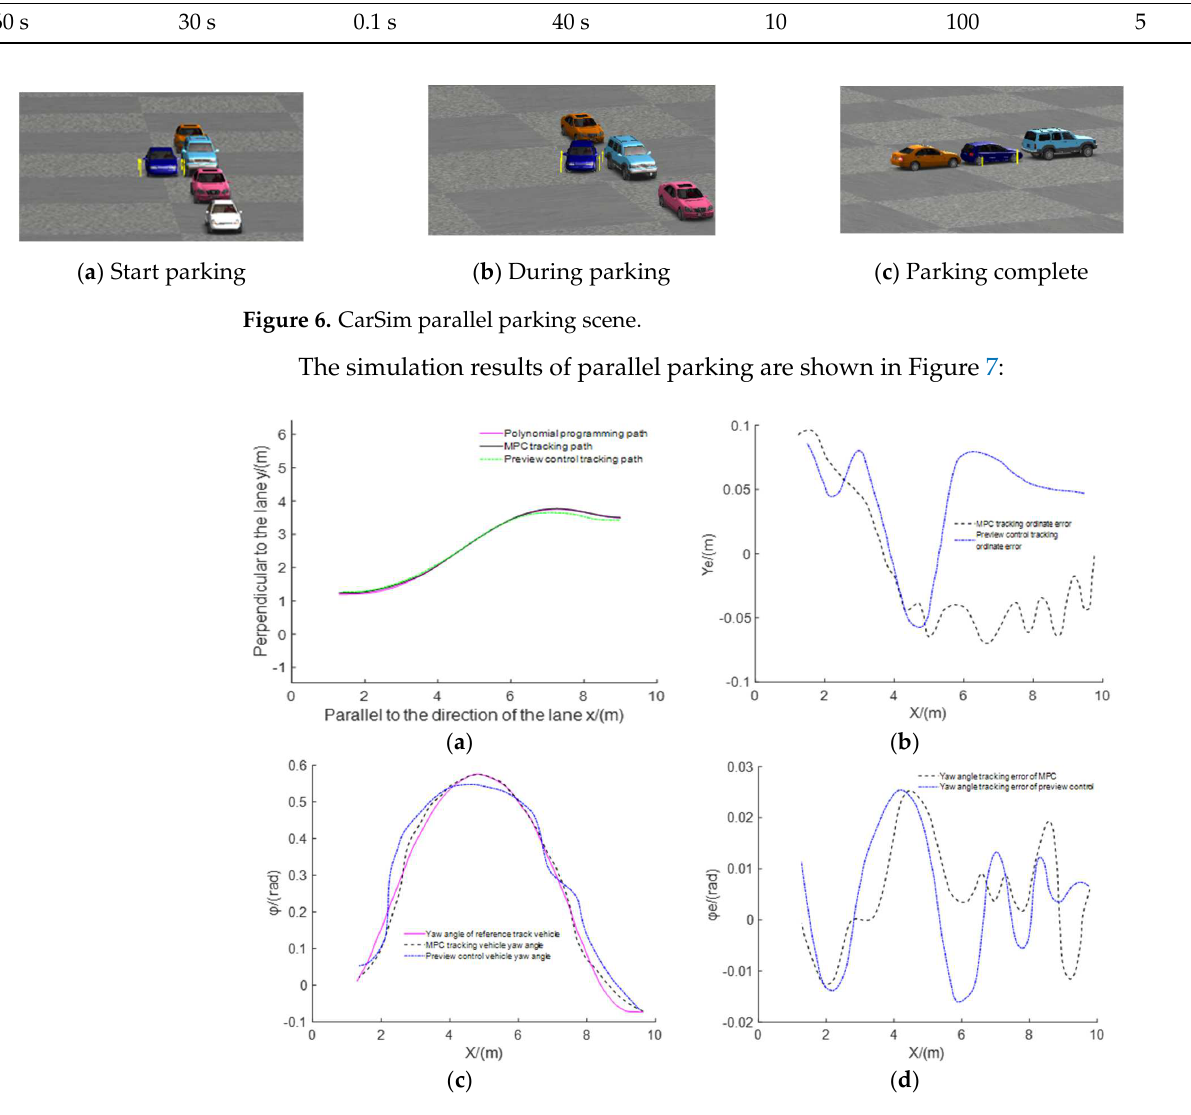
Figure 7. Parallel parking path tracking simulation results. ( a ) Path tracking. ( b ) Ordinate tracking error curve. ( c ) Variation of yaw angle of vehicle. ( d ) Tracking error of vehicle yaw